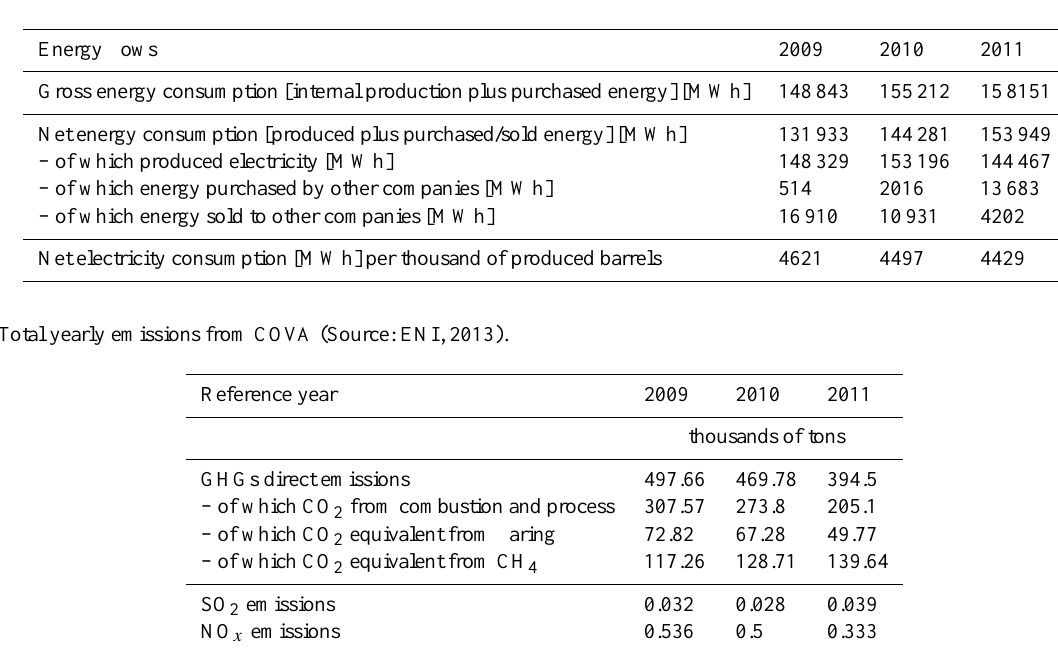
Table 6. Energy consumption of COVA (source: ENI, 2013).